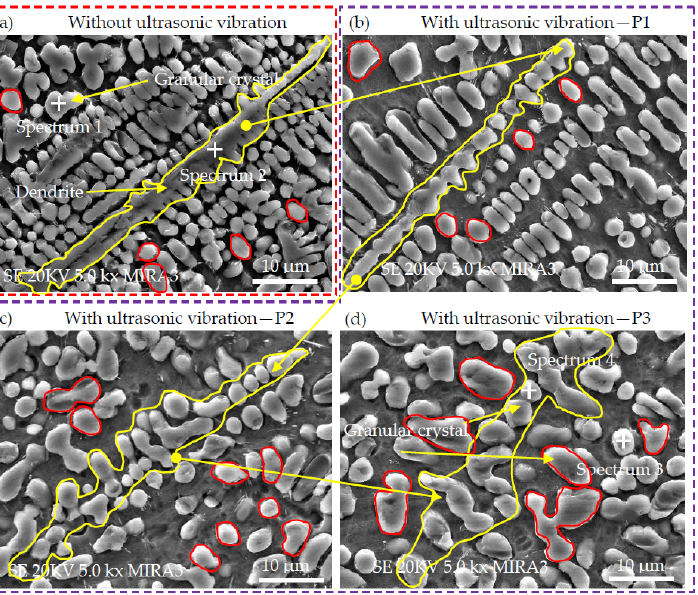
Figure 7. Effect of ultrasonic vibration power on the microstructure of TiC/TiB composite ceramic coating: ( a ) P0-Coating, ( b ) P1-Coating, ( c ) P2-Coating, ( d ) P3-Coating.